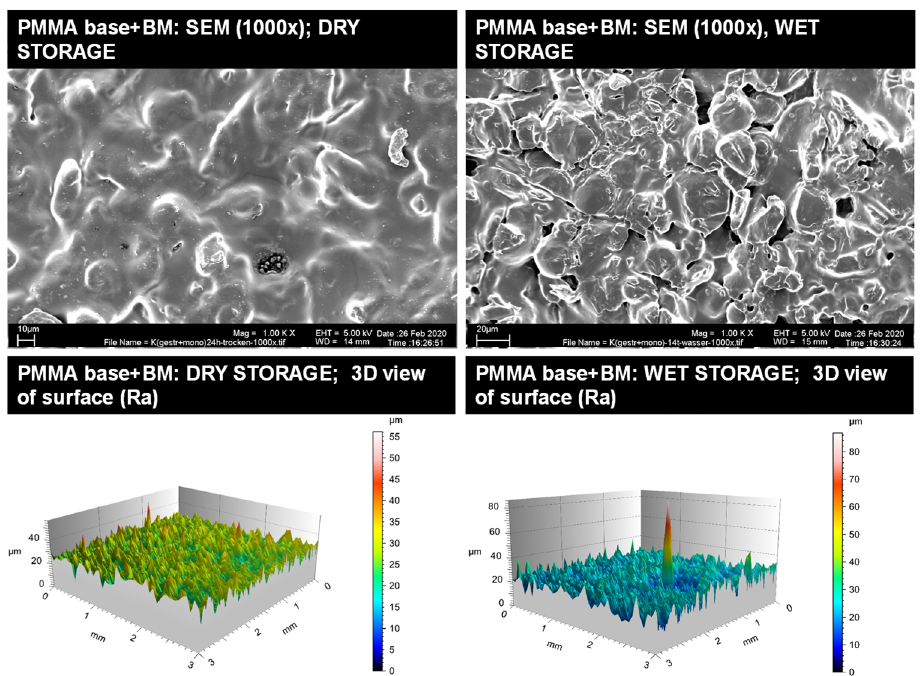
Figure 3. Qualitative insight of the gold standard (PMMA base, blasted and conditioned with MMA) via SEM imaging in 1000 × magnification ( top ) and surface roughness profiles ( below ) for dry storage ( left ) and wet storage ( right ). Please note the differences in the scaling of the roughness profiles.